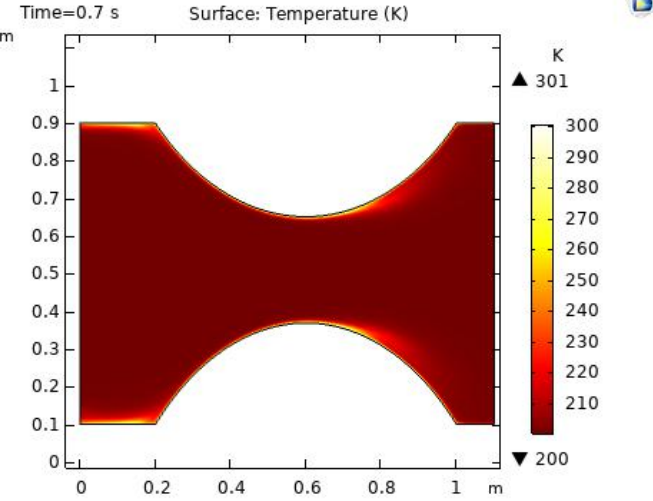
Figure 12. The temperature profile at t = 0.7 s.